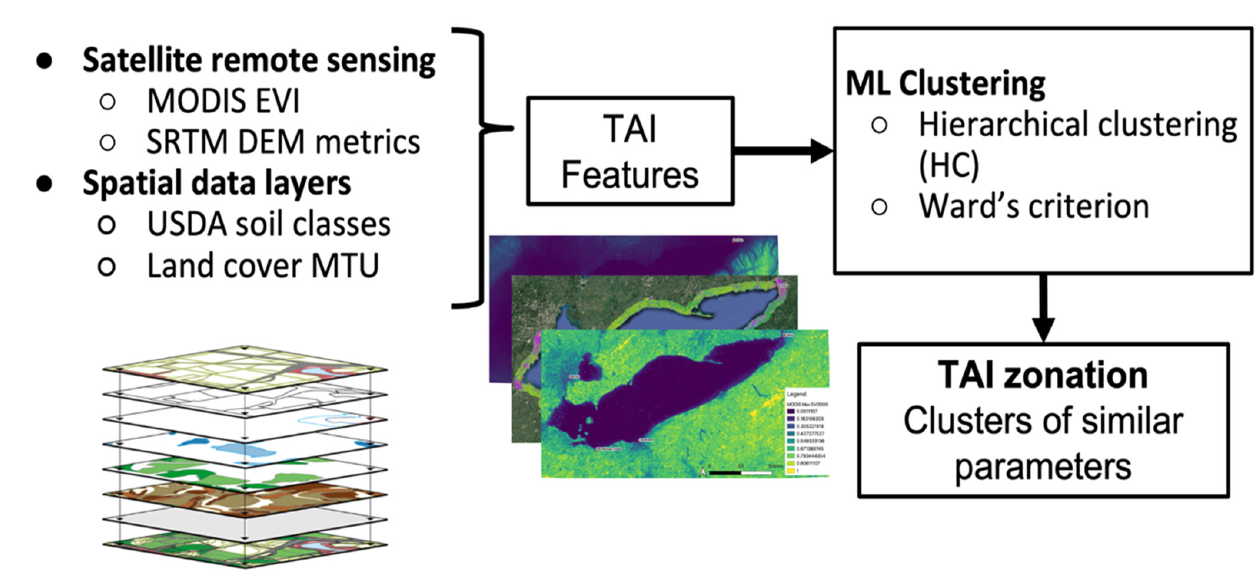
Figure 4. ML hierarchical clustering process.